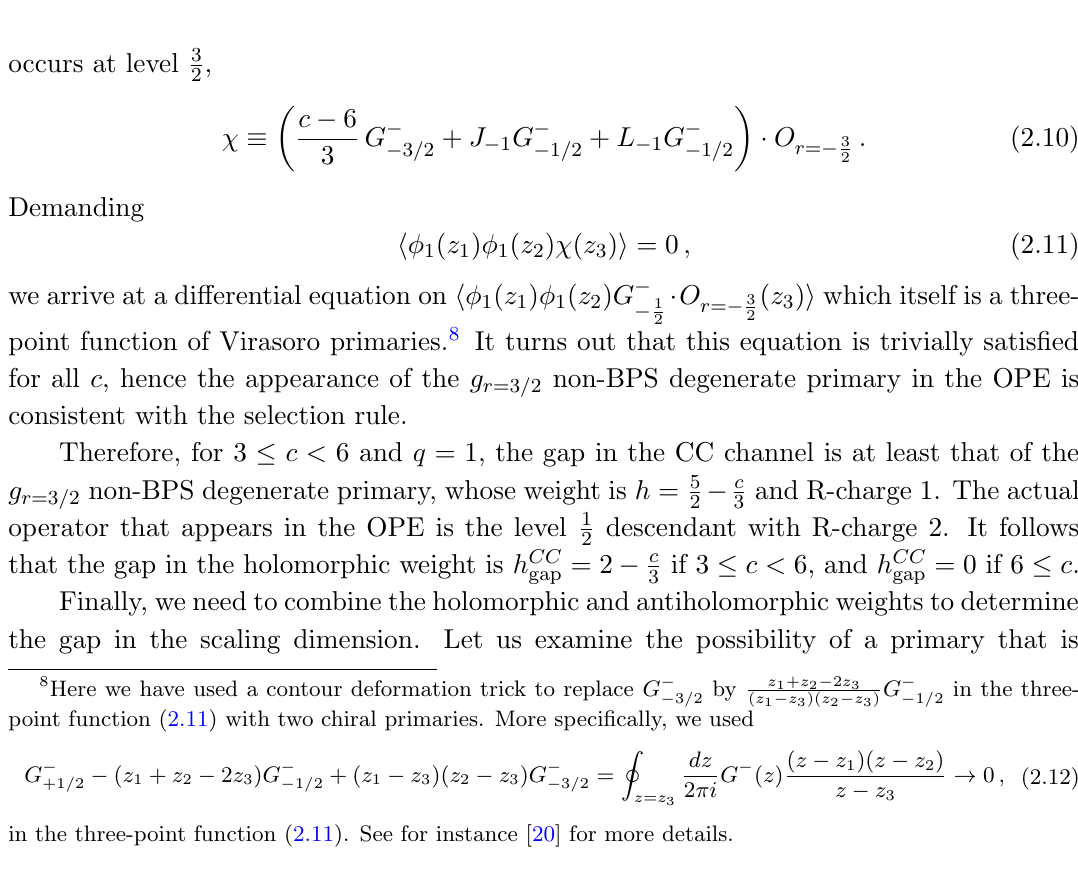
Figure 1. Possible unitary multiplets allowed by the OPE between two chiral primaries of R-charge q = 1. The solid/dashed lines are the degenerate multiplets satisfying g r = 0. In particular, the r = 1 R-charge 2 q = 2, while all the non-BPS primaries carry R-charge 2 q primary is shown in dashed lines for 3 and is not present in unitary CFTs. The gray shaded region corresponds to the continuum of non-degenerate multiplets. Note there is necessarily a gap in the weight above the chiral primary c < if 3 (cid:20)